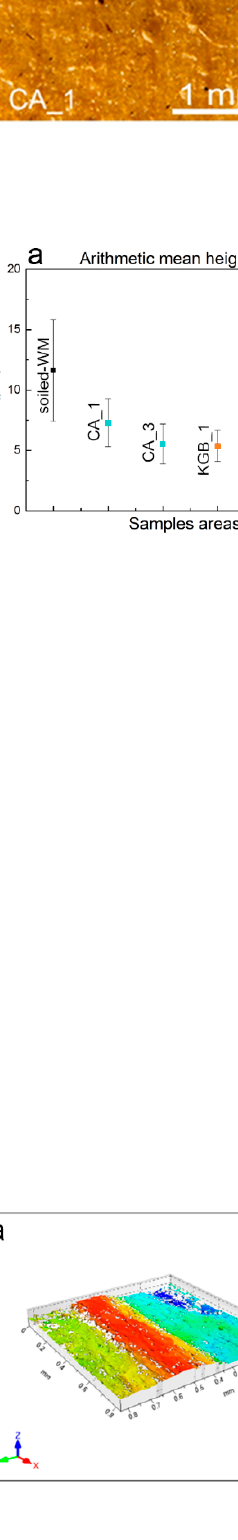
Figure 8. Images by stereomicroscope of the soiled-EAM cleaned by CA gel and KGB gel at different application times CA_1 ( a ), CA_3 ( b ), KGB_1 ( c ), and KGB_3 ( d ). Figure 9. Considered roughness values of Sa ( a ), Ssk ( b ), and Sv ( c ) on the different areas of EAM and soiled − EAM cleaned by different gels and application time CA_1, CA_3, KGB_1, KGB_3, and Agar_3. The complex surface morphology of EAM was also found in the sample contami- nated with sweat (Figure 10), where a large part of the deposition was penetrated inside the wood pores. By observing the cleaning efficacy through Sa and Ssk (Figure 1a,b), both CA and KGB showed similar values: CA and KGB revealed only slight changes from 1 to 3 applications. The Sv parameter, as for the other considered mock-ups, highlights the greater variations as a result of successive gel applications (Figure 11c), in particular for KGB_1 to KGB_3. By comparing these results with those obtained in the area cleaned with Agar_3 (Figure S4f), no significant difference was revealed, with Agar_3 values compara- ble with KGB_3 (Figure 11c).